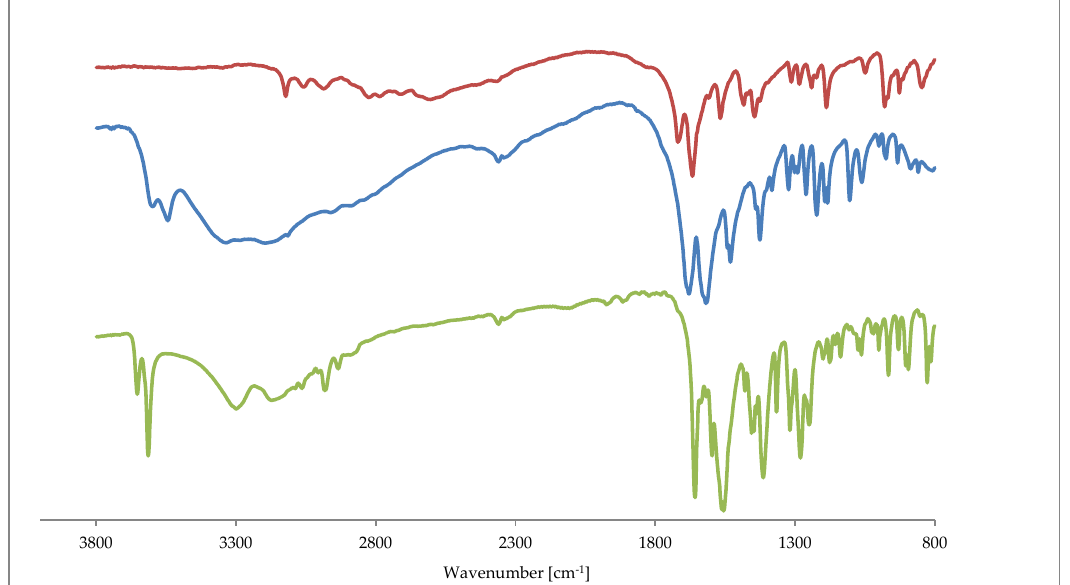
Figure 6. Fourier-transform infrared spectroscopy (FTIR) spectra of theophylline (red line), 1 (blue line) and 2 (green line).